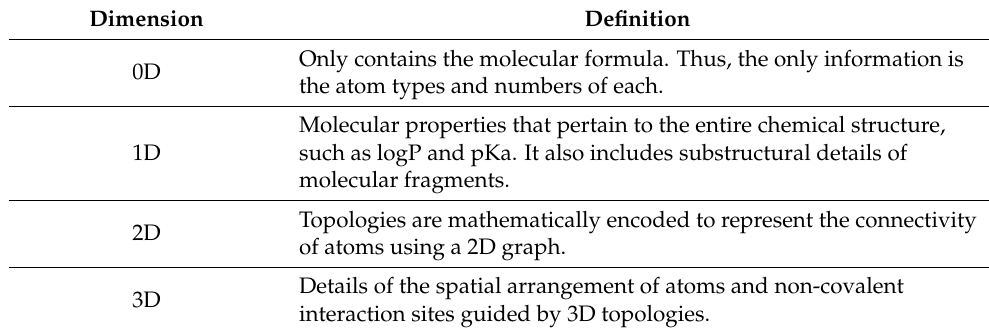
Table 1. Methods for the generation of molecular descriptors for QSAR modelling.